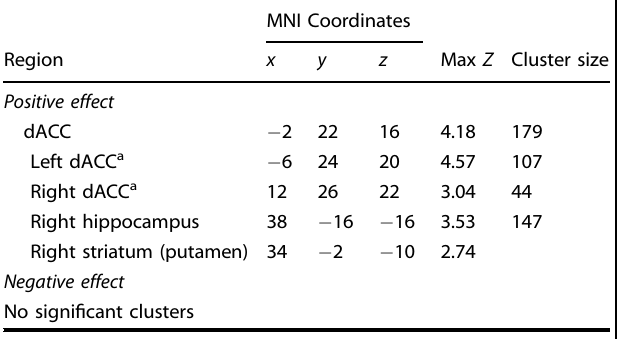
observed in the control group, adj. R 2 = 0.047, F (6,10) = 1.131, p = 0.411. Additional analyses found that functional connectivity amongst the same set of brain regions (left and right dACC, right striatum and hippocampus) did not predict changes in math skills (measured by WJ-III Math Fluency) in the training group, adj.